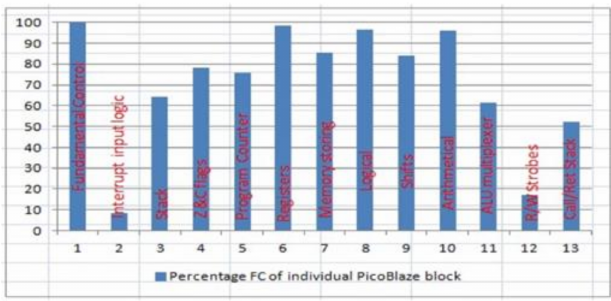
Figure 6. The percentage of FC of individual PicoBlaze